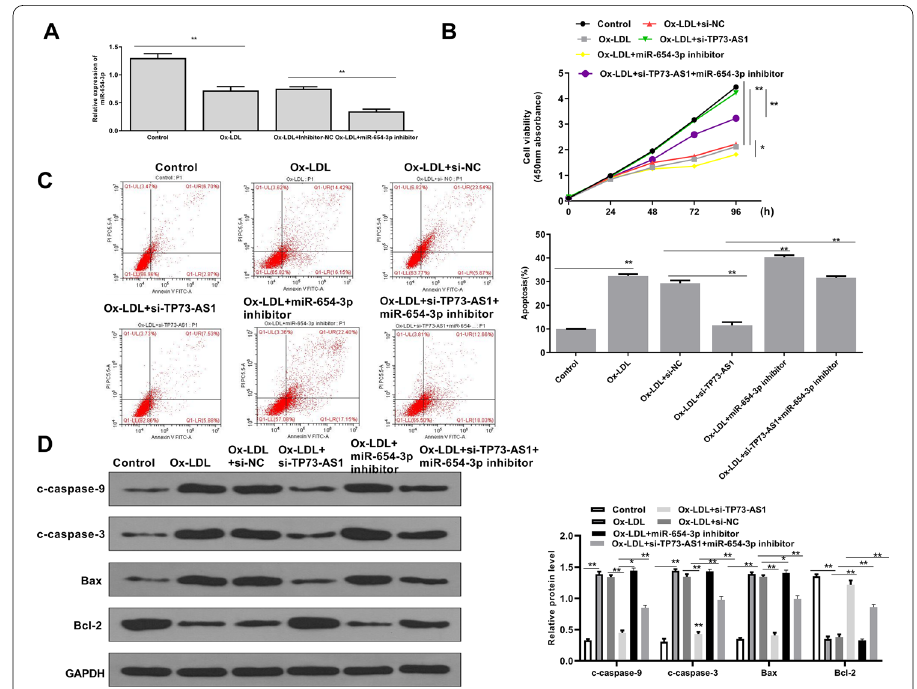
Fig. 5 TP73-AS1 knockdown inhibited apoptosis of ox-LDL treated HAECs by targeting miR-654-3p. A MiR-654-3p level evaluated by qRT-PCR in HAECs transfected with miR-654-3p inhibitor or inhibitor NC and treated with ox-LDL for 24 h. B Cell viability assessed by CCK-8 assay, C apoptosis evaluated by flow cytometry and D the levels of apoptosis-related proteins detected by Western blot in HEACs with si-TP73-AS1, si-NC, miR-654-3p inhibitor, or co-transfected with si-TP73-AS1 and miR-654-3p inhibitor, and treated with 50 μg/ml ox-LDL for 24 h. *P < 0.05, **P <